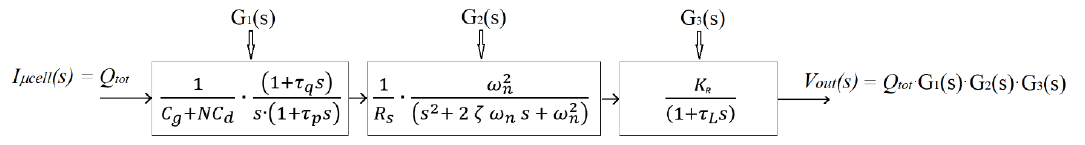
Figure 4. Simplified block diagram of the system.